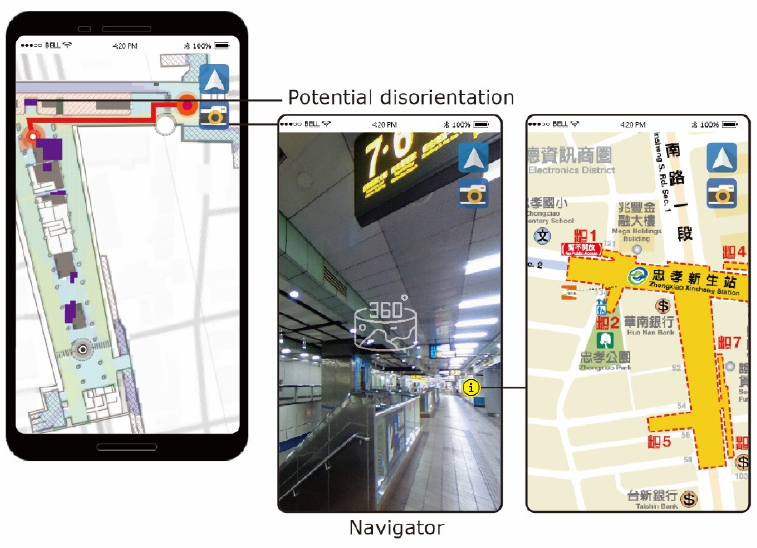
Figure 6. Components of Rideway for enhancing wayfinding.